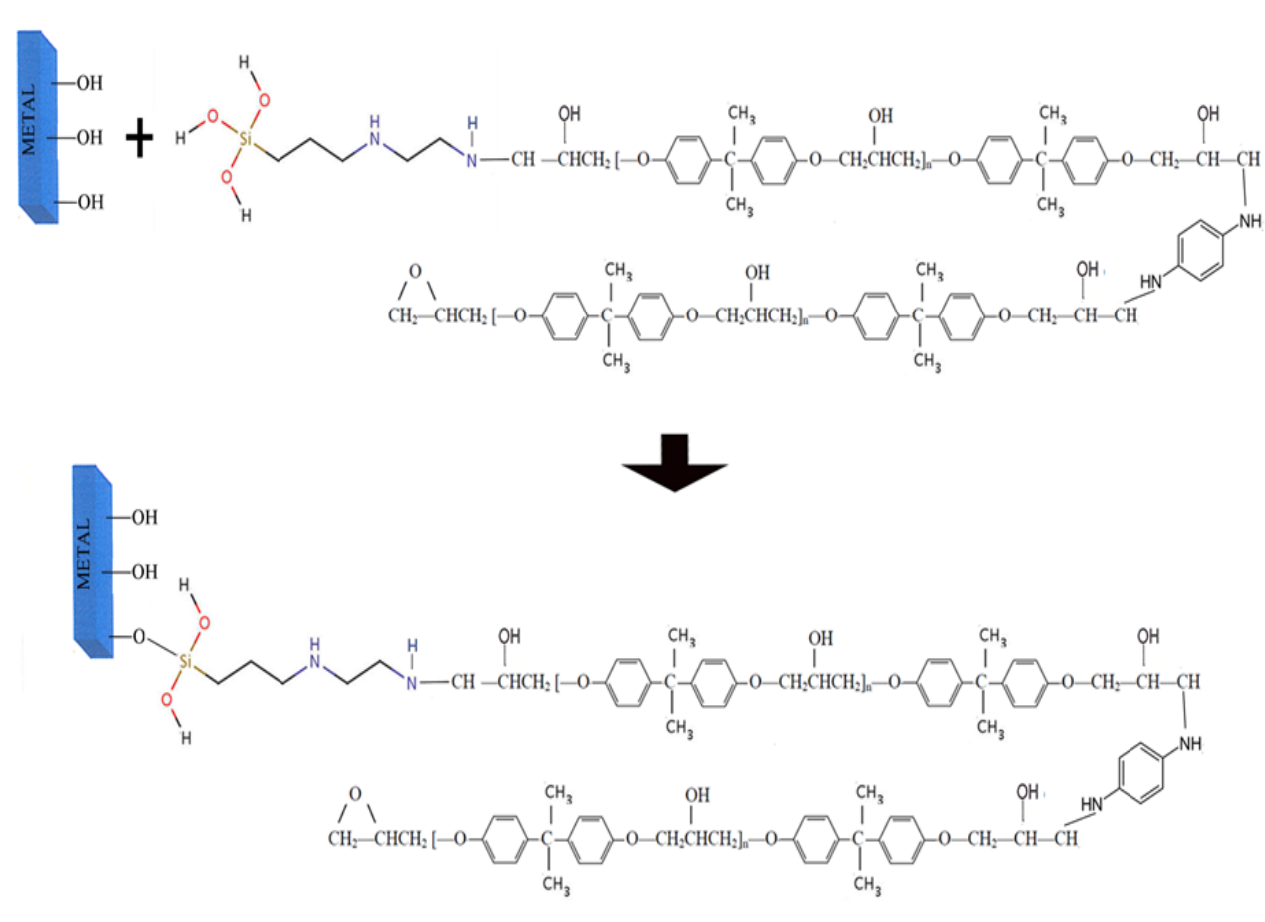
Figure 6. Attachment of a hybrid coating to the surface of the metal.